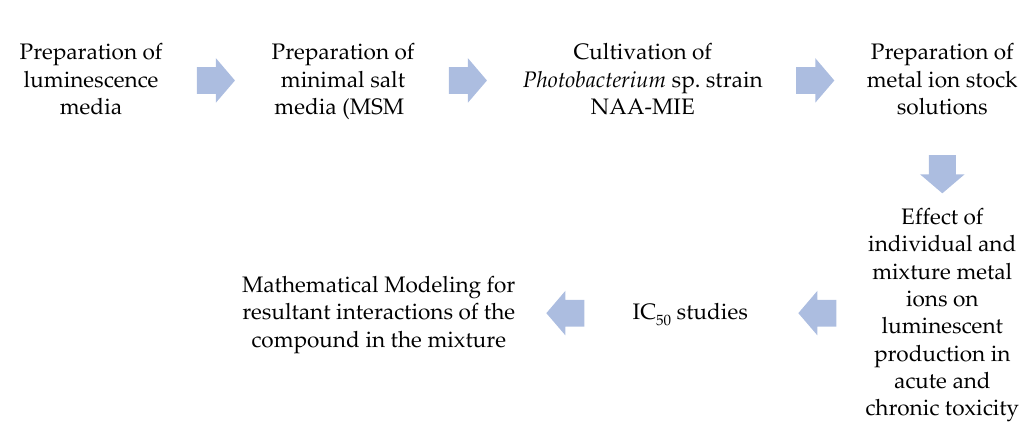
Figure 1. Steps in the experimental procedure for the determination of interaction existing between compounds in acute and chronic toxicity of Photobacterium sp.NAA-MIE against 6 heavy metal.